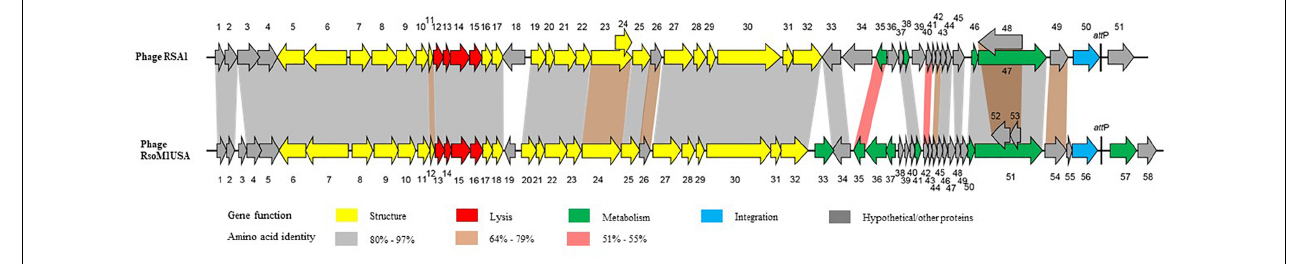
FIGURE 2 | Comparison of genomic organization between phages RsoM1USA and RSA1. Different functional gene groups are represented and different levels of amino acid sequence identity between homologous ORFs are shaded with different colors. The location of the core attachment att P site is indicated in the two phages.